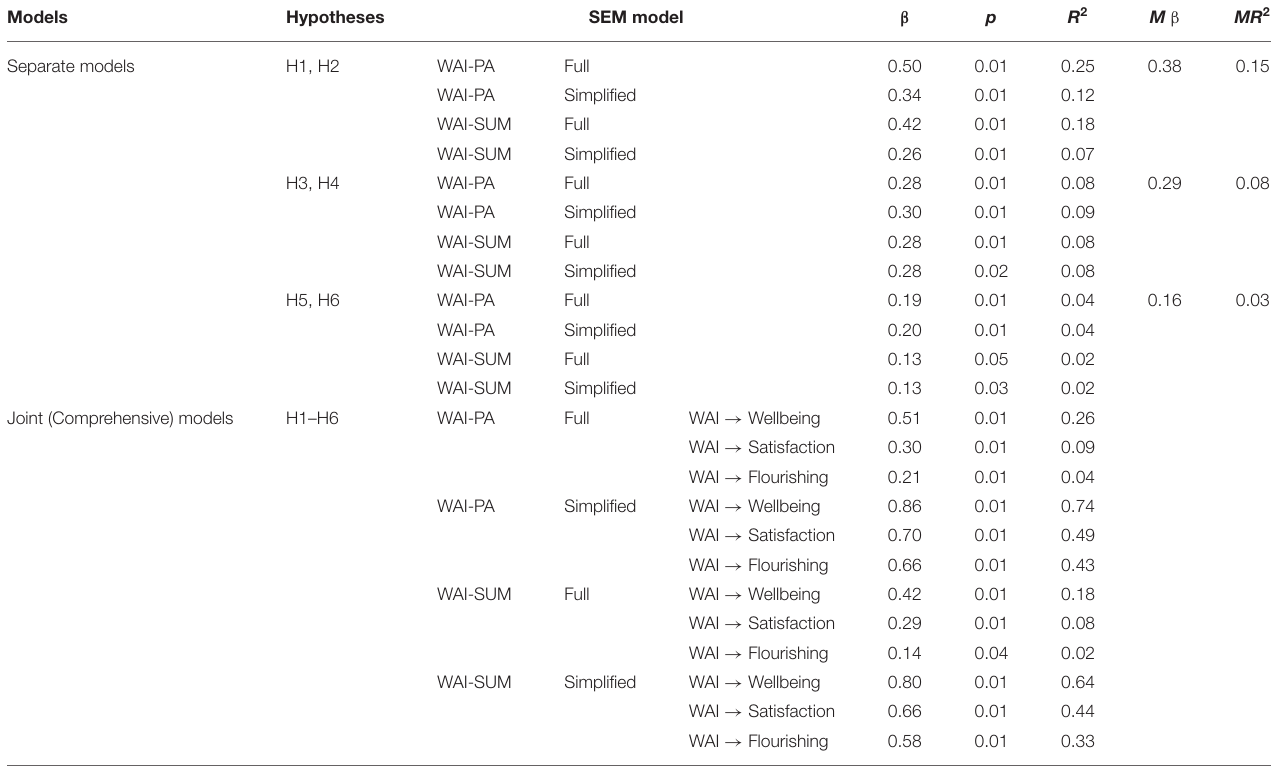
TABLE 2 | Standard estimators of the tested